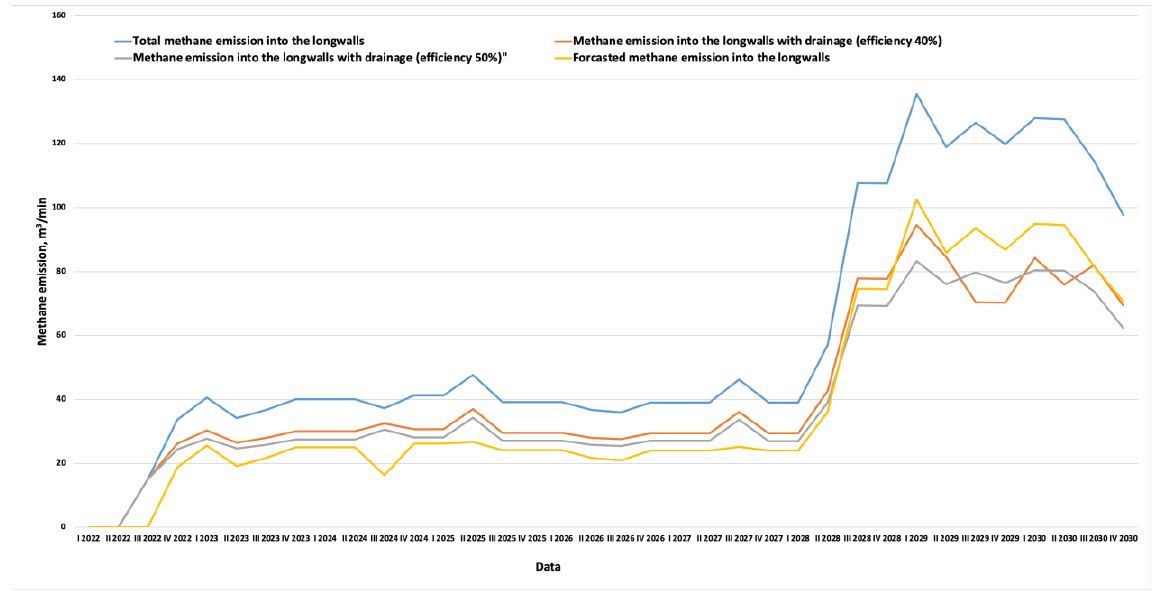
Figure 8. Total methane emission into the mine workings between the years 2022 and 2030.